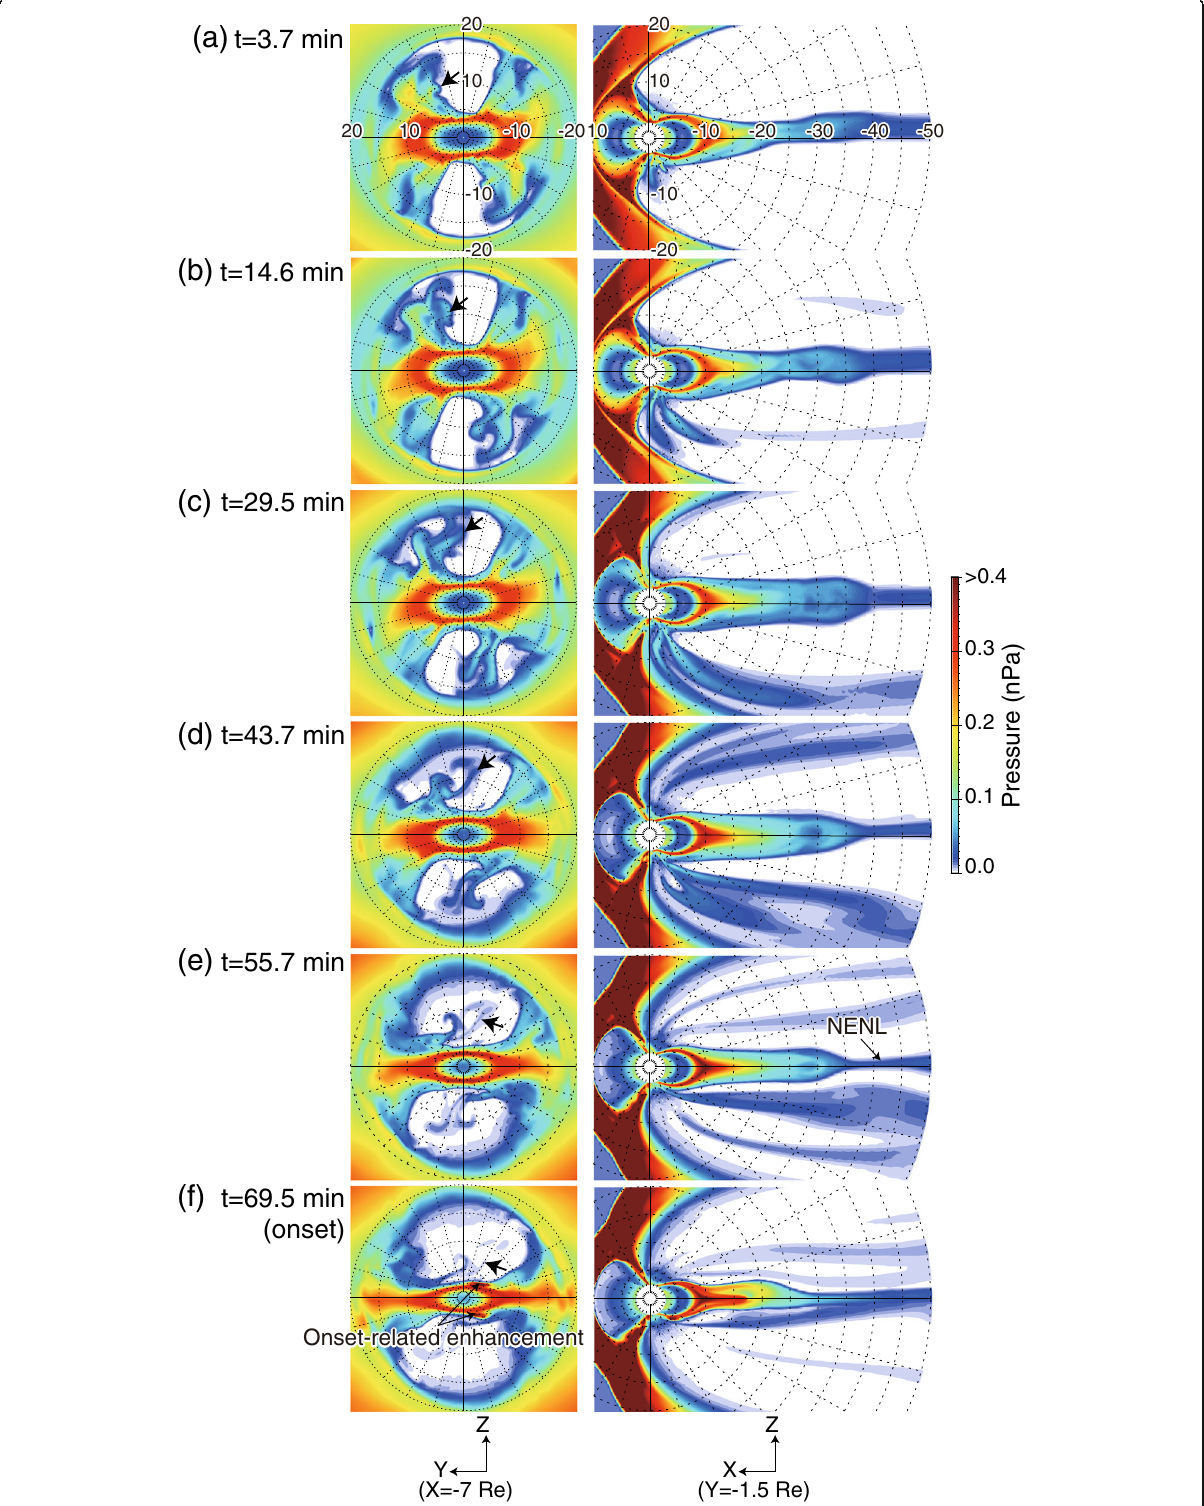
Fig. 4 Plasma pressure in the Y - Z plane at X = − 7.0 Re (left), and in the X - Z plane at Y = − 1.5 Re (right) at a 3.7, b 14.6, c 29.5, d 43.7, e 55.7, and f 69.5 min. (Adapted from Ebihara and Tanaka